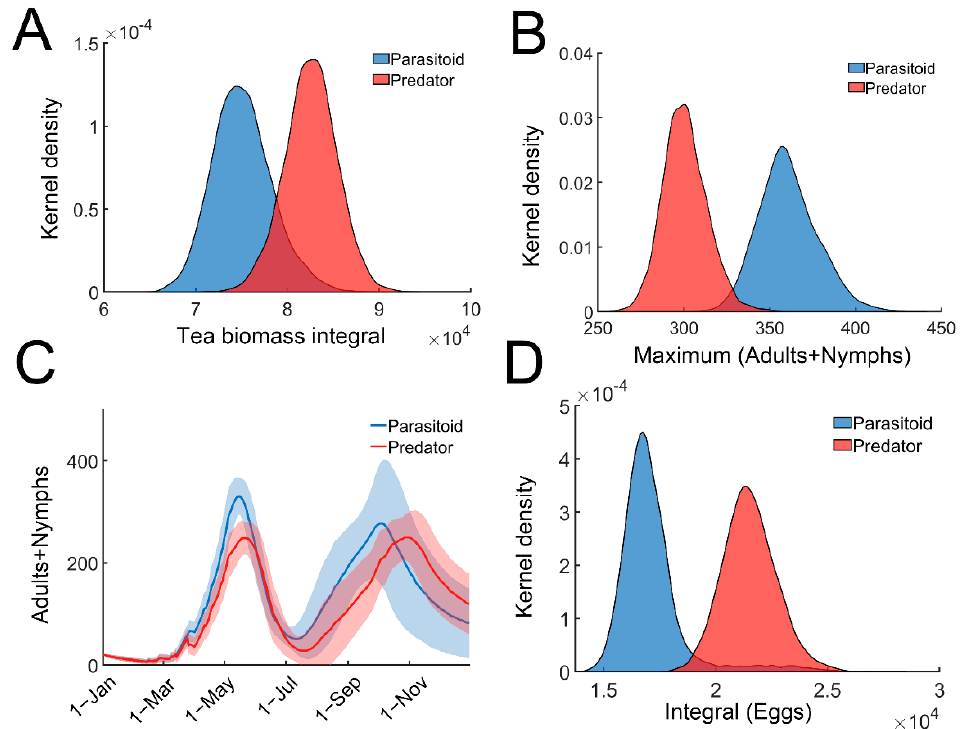
Figure 4. Comparing the efficiency of predators and parasitoids. ( A ) Distribution of the tea crop integral (tea yields) in predator (red) or parasitoid (blue) model. ( B ) Distribution of the maximal TGLs (adults + nymphs) in predator (red) or parasitoid (blue) model. ( C ) Temporal trajectories of maximal TGLs (adults + nymphs) in predator (red) or parasitoid (blue) model. Trajectories were averaged over 2000 simulations with 95% confidence intervals (shaded area). ( D ) Distribution of the temporal integral of eggs in predator (red) or parasitoid (blue) model.